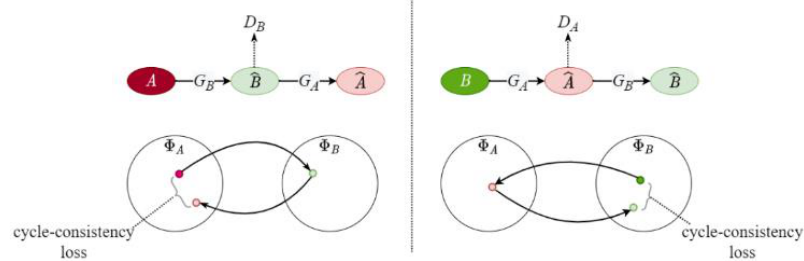
Figure 3. Cycle consistency mapping [13].